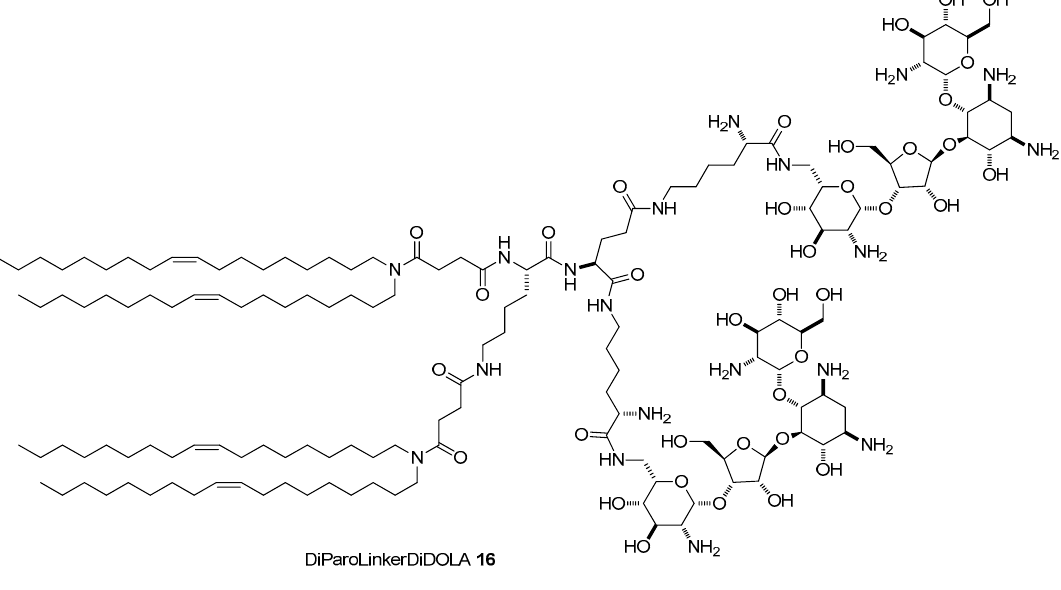
Figure 7. Structure of diparomomycin lipid 16 .